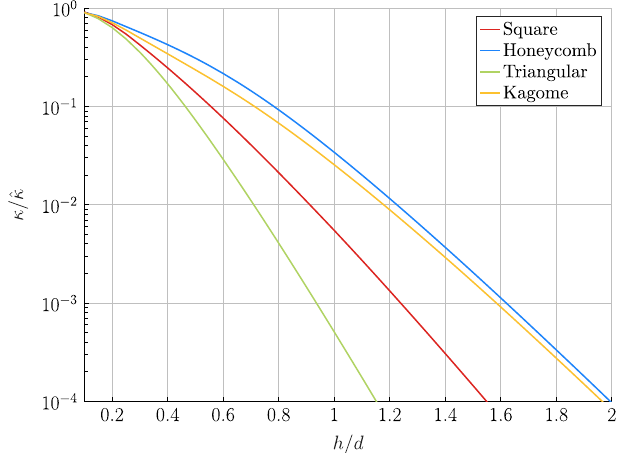
FIG. 4. Dimensionless curvatures κ as functions of the ratio of microtrap height h to interion spacing d , for several lattice geometries.